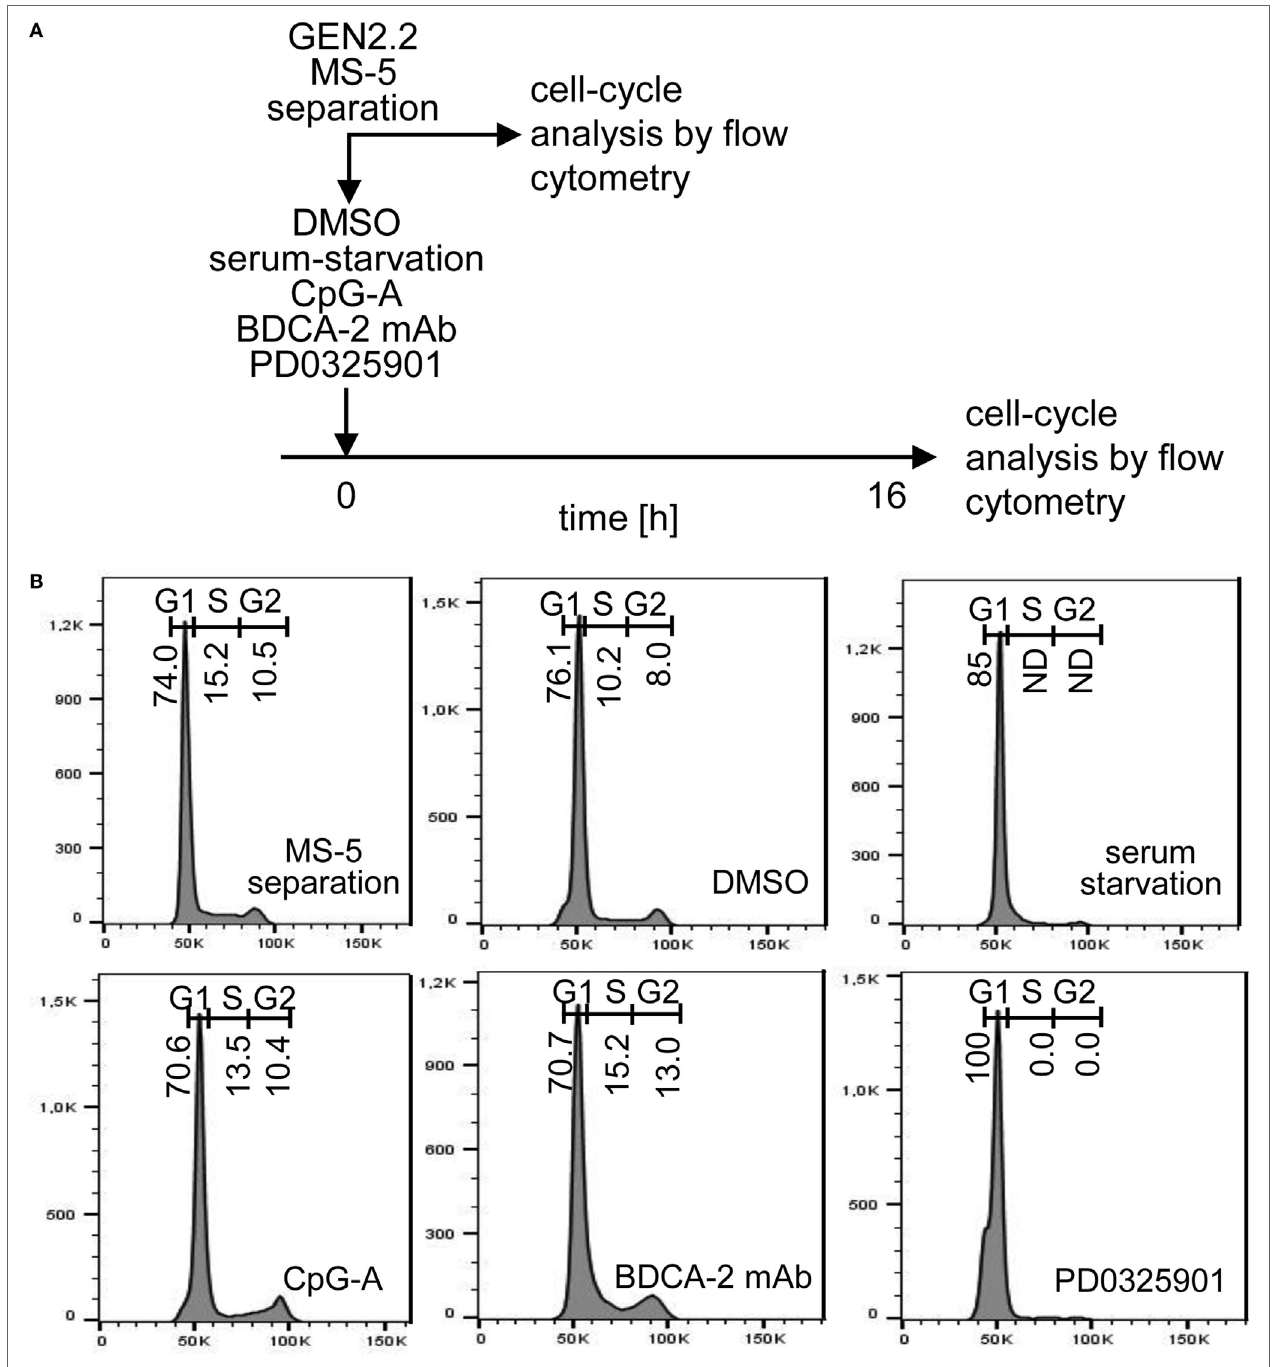
FigUre 9 | Cell cycle analysis of GEN2.2 cells cultured in the presence of PD0325901, CpG-A, blood dendritic cell antigen 2 (BDCA-2) mAb, or in serum-free medium. (a) Experimental outline. GEN2.2 cells separated from MS-5 feeder cells were exposed for 16 hr to 1 µM PD0325901, 4 µg/ml CpG-A, 0.25 µg/ml BDCA-2 mAb, or DMSO (mock-treated control), or analyzed immediately after separation from MS-5 cells. (B) Cell cycle analysis using Hoechst 33342 stain. Histograms of live GEN2.2 cells (representative result of three independent experiments) stained with Hoechst 33342 dye showing DNA content distribution. Live/ Dead cell discrimination was performed by Zombie Green ™ Fixable Viability Kit. ND, not